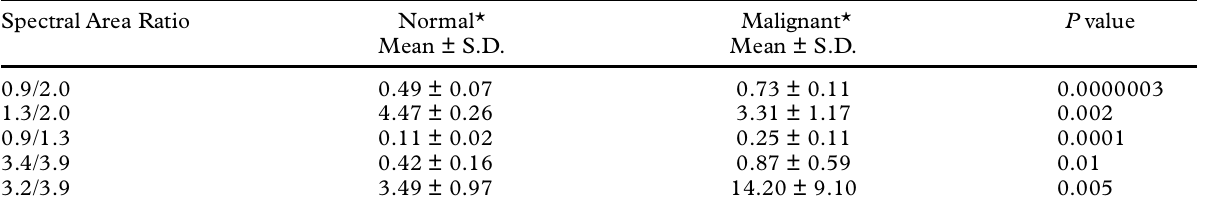
Table 2. Comparison of mean values of 1 H MR spectral area ratios in soft tissue sarcoma Spectral Area Ratio Normal* Malignant* P value Mean ± S.D. Mean ± S.D.